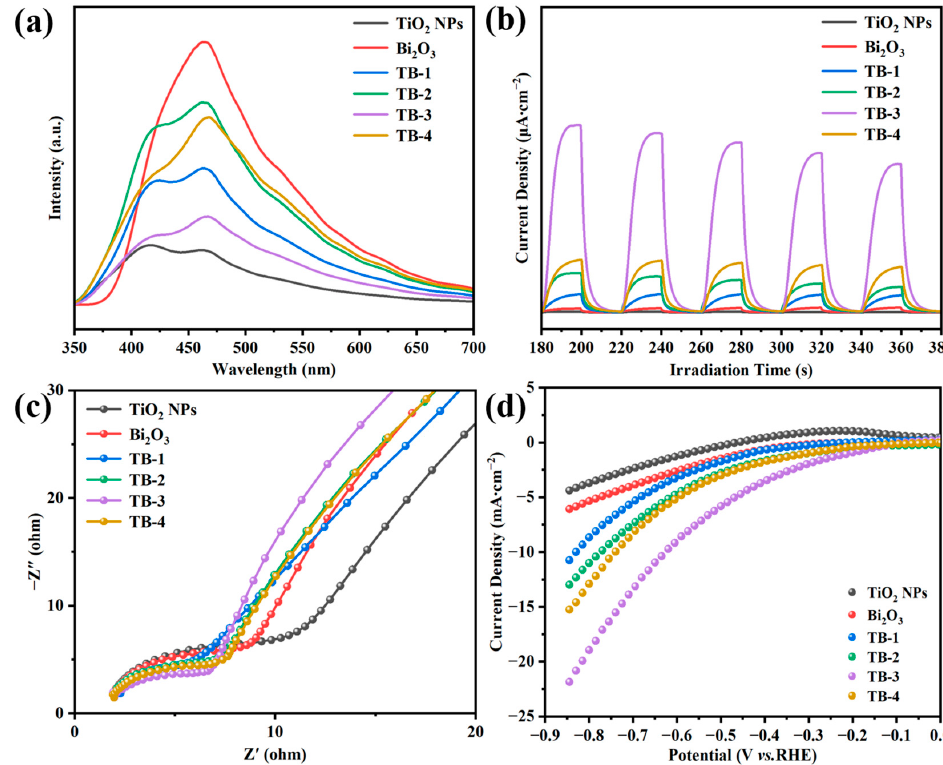
Figure 7. ( a ) Photoluminescence (PL) emission spectra. ( b ) Photocurrent response. ( c ) EIS Nyquist plots, ( d ) LSV curves of TiO 2 NPs, Bi 2 O 3 , and TB-x (x = 1–4).